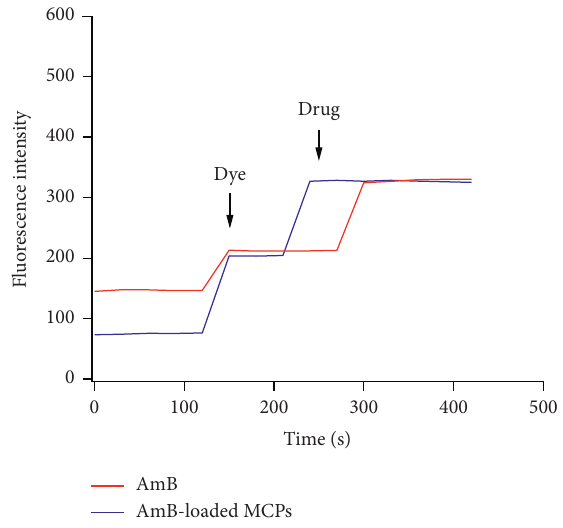
Figure 4: Membrane depolarization of Candida albicans cells by AmB-MCPs and free AmB using DiBAC 4 (3)